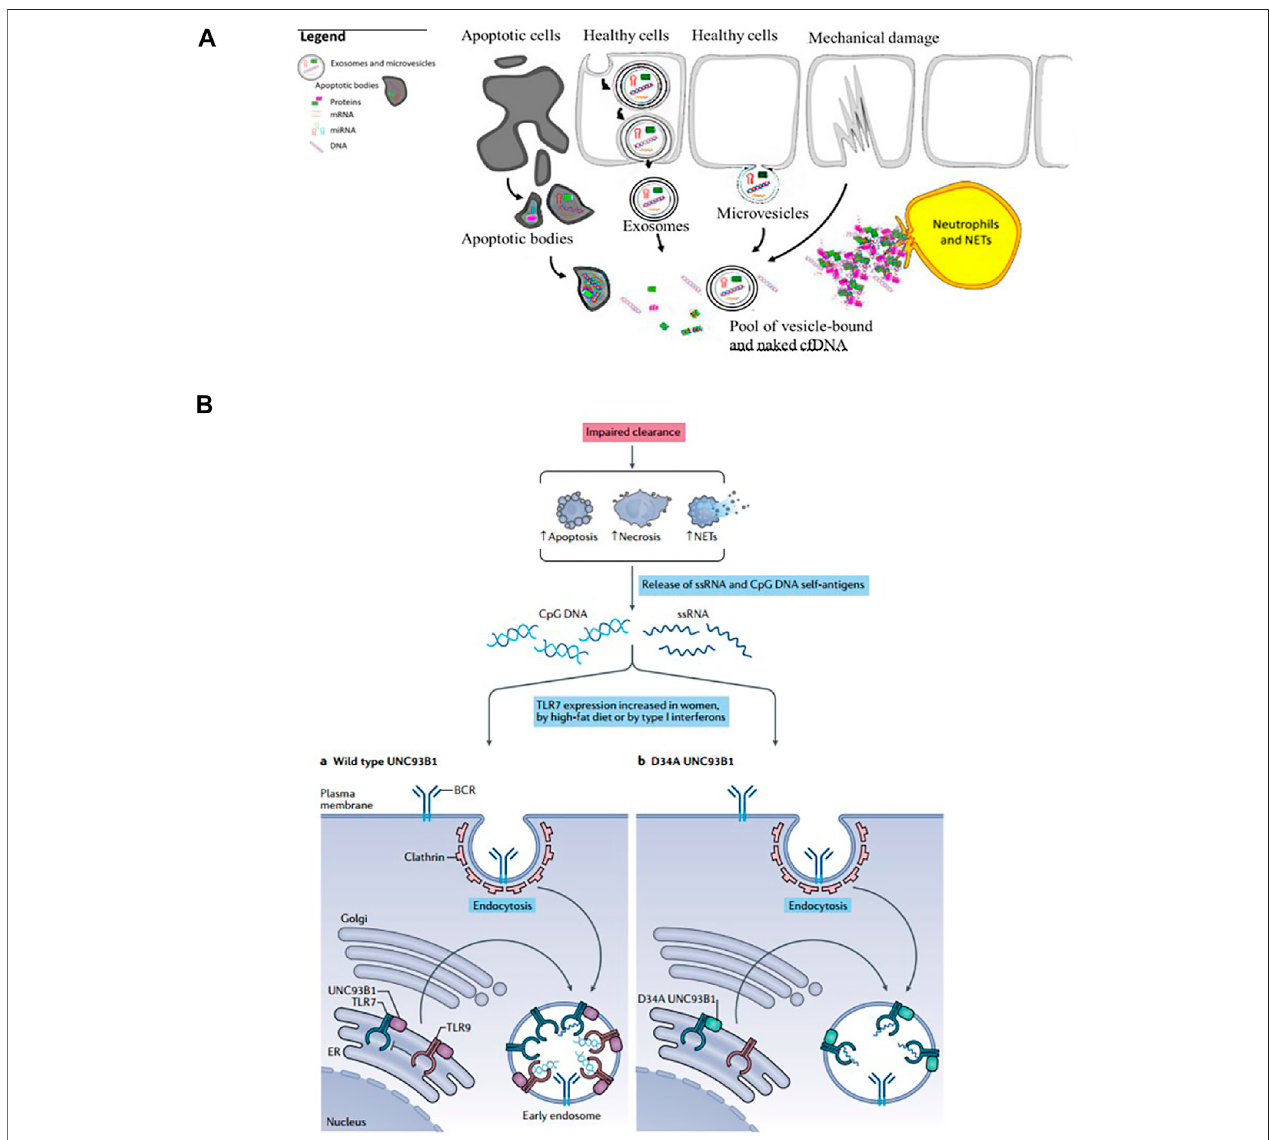
FIGURE 2 | The sources and mechanism of cfDNA. (A) Endogenous sources of cfDNA including apoptotic bodies, exosomes, microvesicles, neutrophil extracellular traps (NETs), necrosis (Reprint from Ref (Kubiritova et al., 2019)). (B) cfDNA induces in fl ammatory responses and the occurrence and development of in fl ammatory diseases (Reprint from Reference (Fillatreau et al., 2021)).